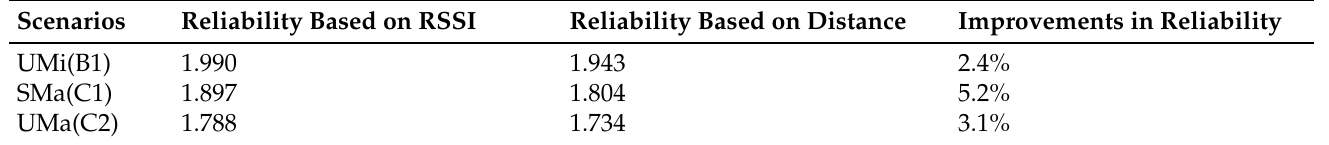
Table 8. Simulation results for reliability under different